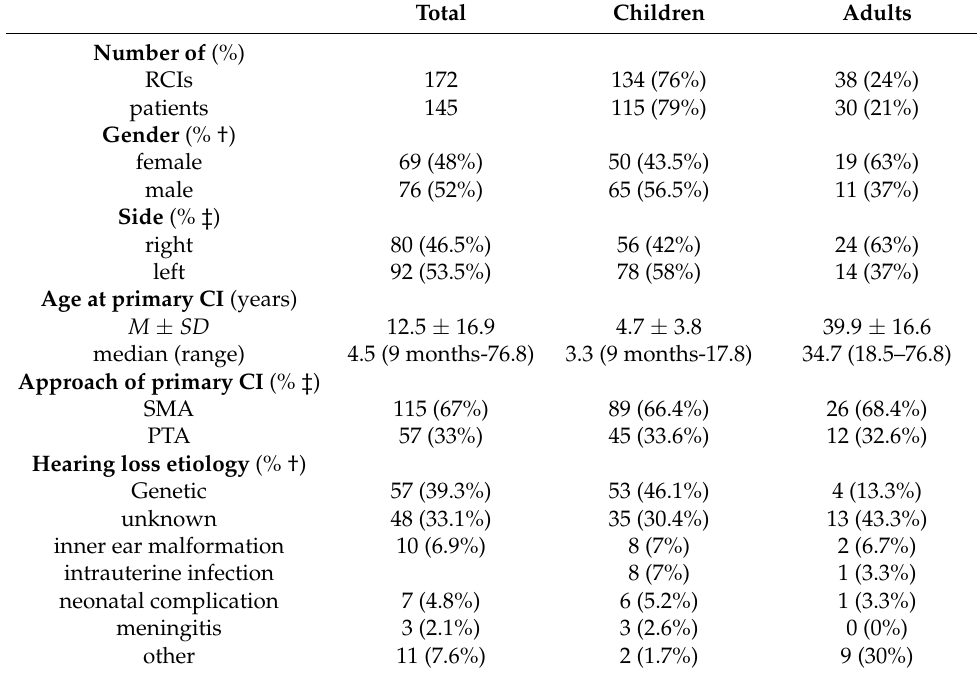
Table 1. Demographic variables.